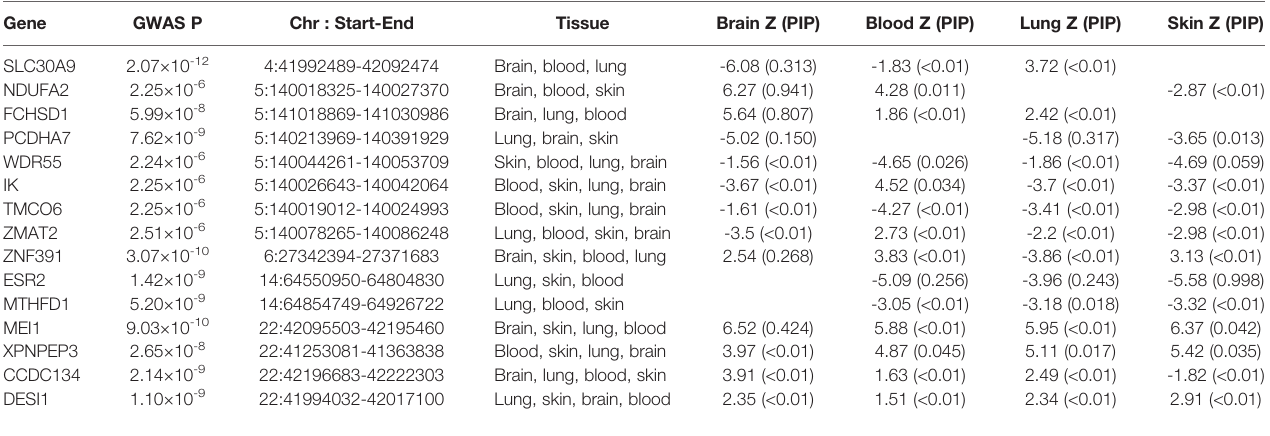
TABLE 2 | TWAS analysis in the four tissues.